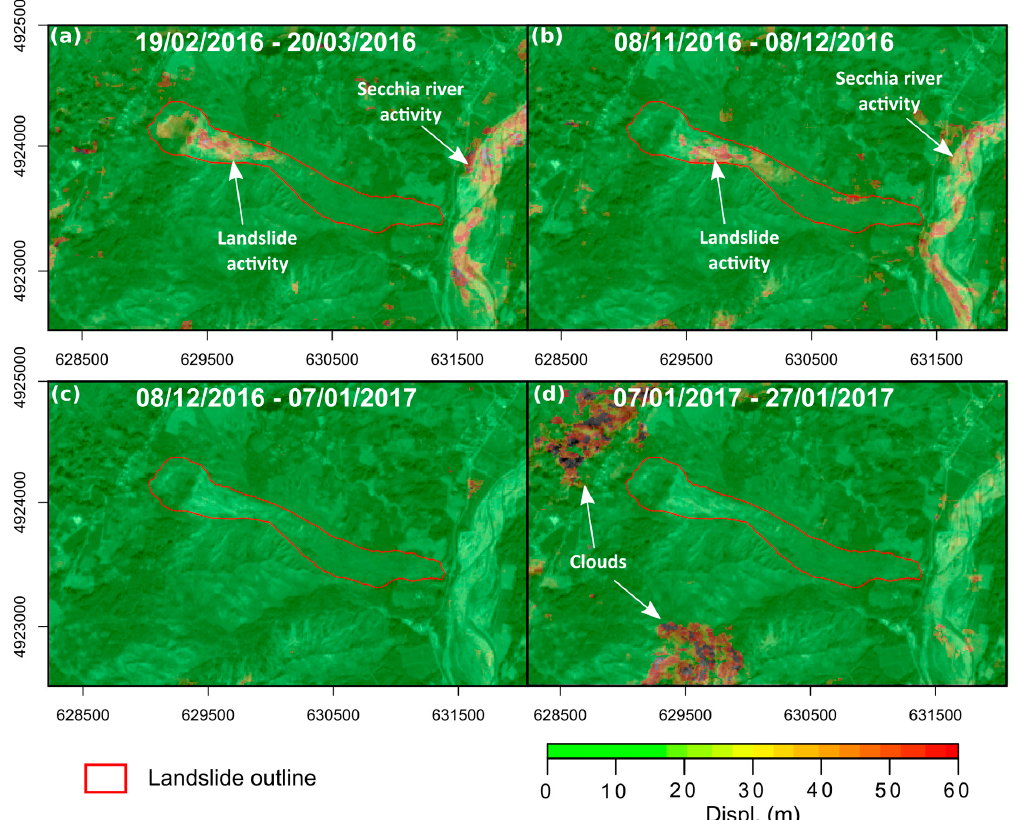
Figure 5. Changes occurring in the area of interest evidenced by digital image correlation results. ( a , b ) Landslide activity and Secchia river dynamics. ( c ) No landslide and river activity. ( d ) Cloud cover effect. Grid coordinates: WGS84/UTM32N (EPSG: 32632).